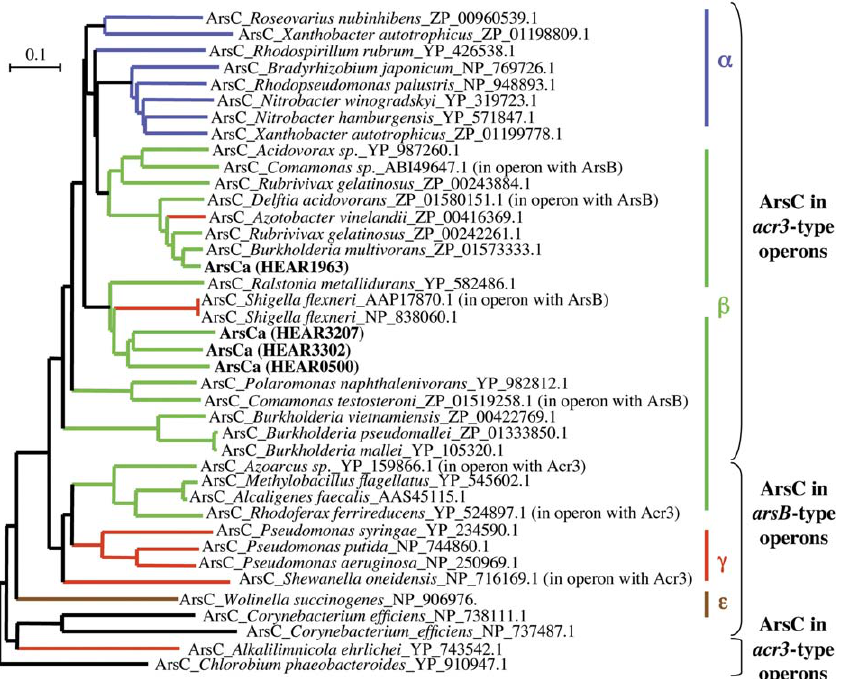
Figure 5. Phylogenetic Tree of ArsCa Arsenate Reductases in Various Arsenic-Resistant Microorganisms The proteins of loci 1 (HEAR3302), 2 (HEAR0500), and 4 (HEAR3207) in cluster with reductases present in acr3 -type transporter operons. In H. arsenicoxydans, two of them are, however, associated with an ArsB-type transporter . Protein sequences involved in arsenate reduction were retrieved from the National Center for Biotechnology Information GenBank database (http://www.ncbi.nlm.nih.gov/entrez) and phylogenetic trees were reconstructed from multiple sequence alignments using the neighbor-joining algorithm implemented in ClustalX. The following sequences were